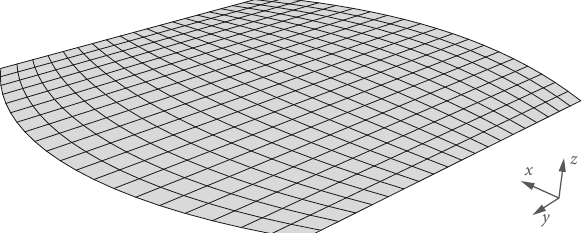
Figure 6: Base mesh resembling the shell footprint, prior to de- formation by virtual forces acting in the reverse order to the real loads.